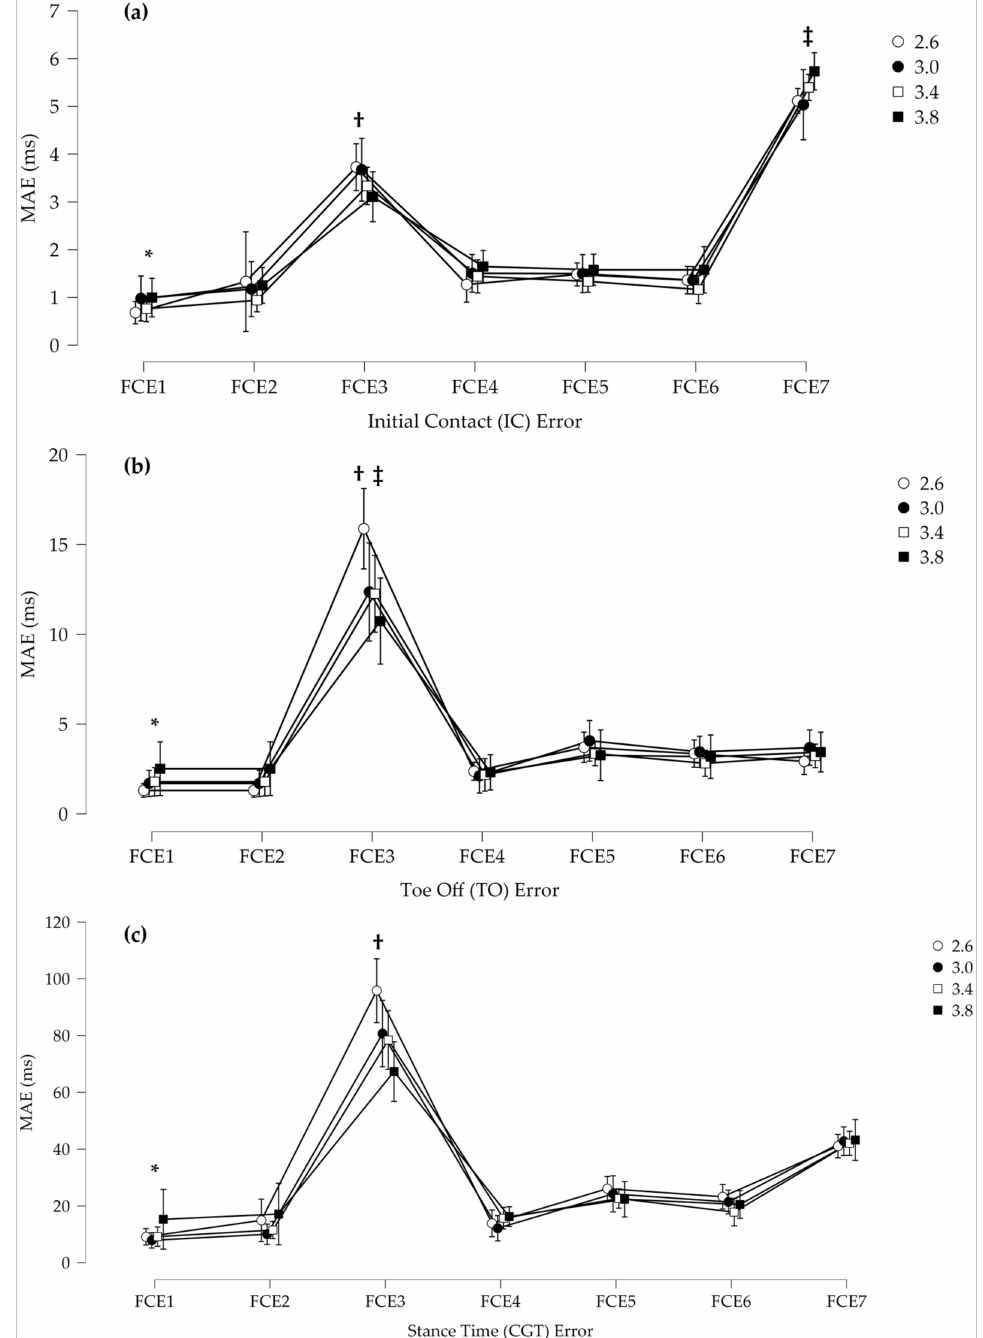
Figure 11. ( a ) Mean absolute error (MAE) for the detection of initial contact (IC). * FCE1 was significantly smaller than all other algorithms, † FCE3 was significantly higher than all others except FCE7, and ‡ FCE7 was significantly higher than all other FCE algorithms. ( b ) MAE for the detection of toe off (TO). * FCE1 had significantly smaller than FCE3 and FCE7, † FCE3 was significantly higher than all other algorithms, and ‡ FCE3 was significantly higher at 2.6 m/s than all other speeds. ( c ) MAE for stance time (GCT). * FCE3 was significantly higher than all other algorithms by speed, and † FCE7 was significantly higher except for FCE3 than all other algorithms. Error bars represent standard